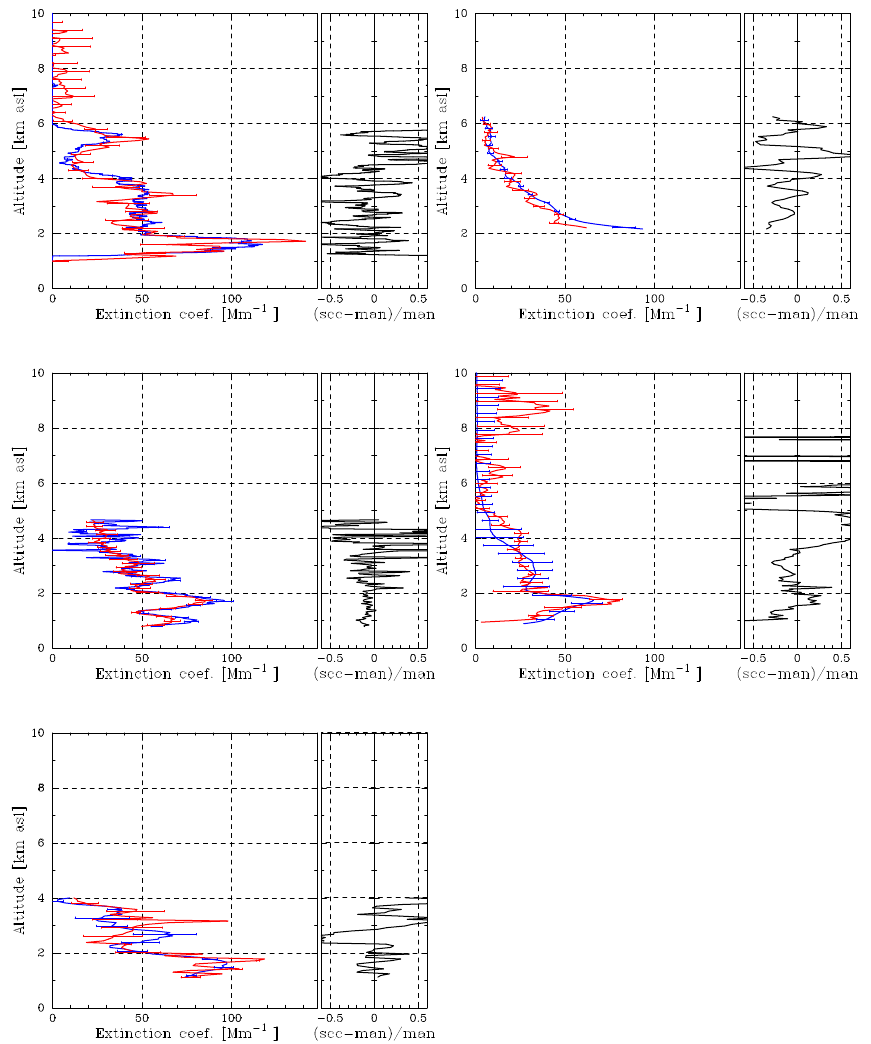
Figure 8. Comparison of extinction coefficient profiles at 532nm derived with the Raman method for five lidar systems participating in the EARLI09 inter-comparison campaign. All profiles refer to the measurement session taken from 21:00 to 23:00UT on 25 May 2009, and they have been retrieved using the N 2 Raman backscatter signals at 607nm. The profiles in blue are the analyses provided by the originator of the data using his/her own analysis software. The profiles in red are the ones retrieved by the SCC. From left to right, upper panel: RALI, MARTHA; middle panel: Polly XT , MSTL-2, bottom panel: